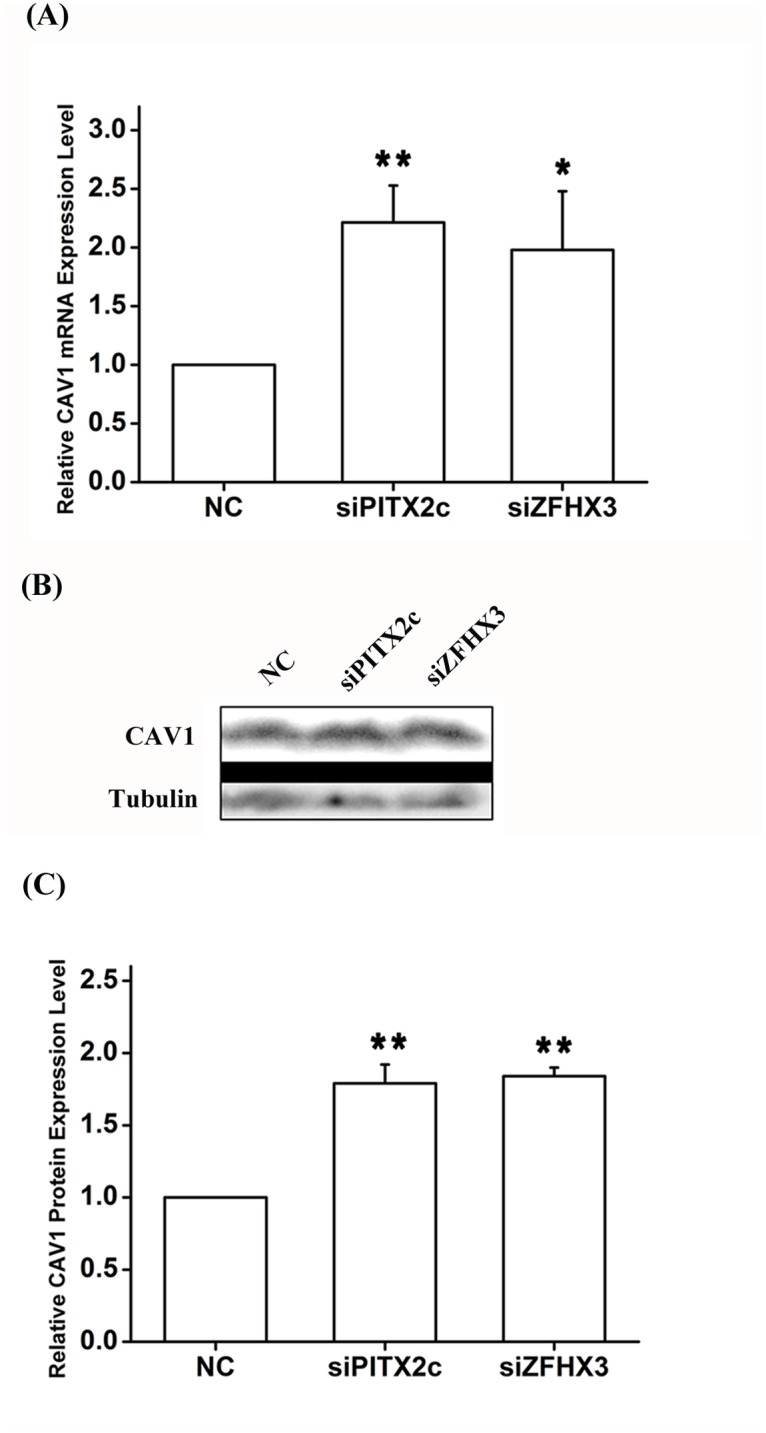

PITX2c and ZFHX3 negatively regulate expression of the CAV1 gene.HCT116 cells were transfected with siRNA specific for PITX2c or siRNA specific for ZFHX3 and used for isolation of total RNA samples and real-time RT-PCR analysis. A. Real-time RT-PCR analysis for CAV1. Transfection of siRNA for PITX2c or siRNA for ZFHX3 successfully increased expression of CAV1. B, C. Western blot analysis revealed that PITX2c and ZFHX3 increased the expression of the CAV1 protein by 1.79-fold and 1.84-fold, respectively (P = 2.21×10-5, 2.00×10-7). **P<0.01; *<0.05.